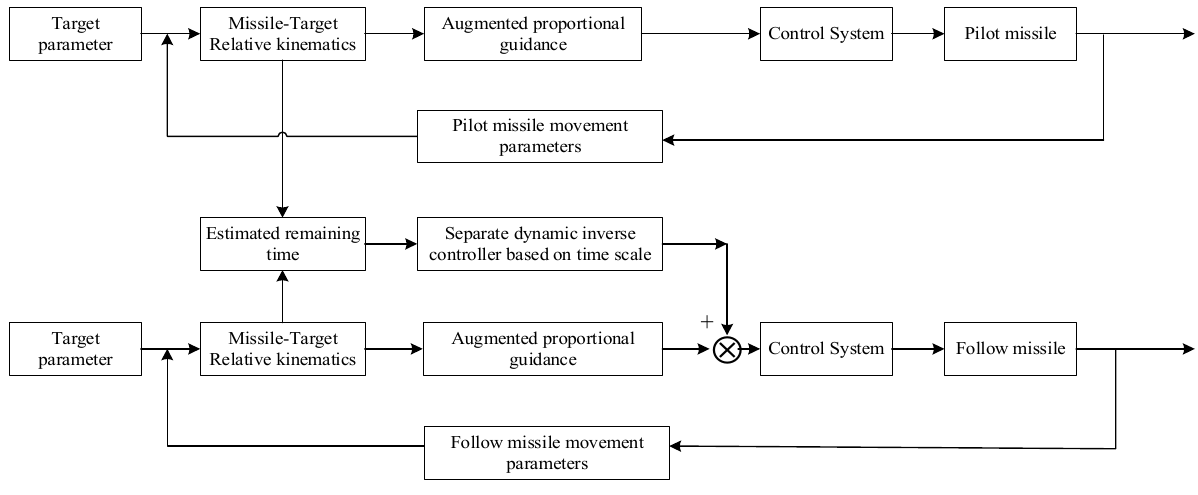
Figure 3. Control flow chart for cooperative guidance of multiple missiles.